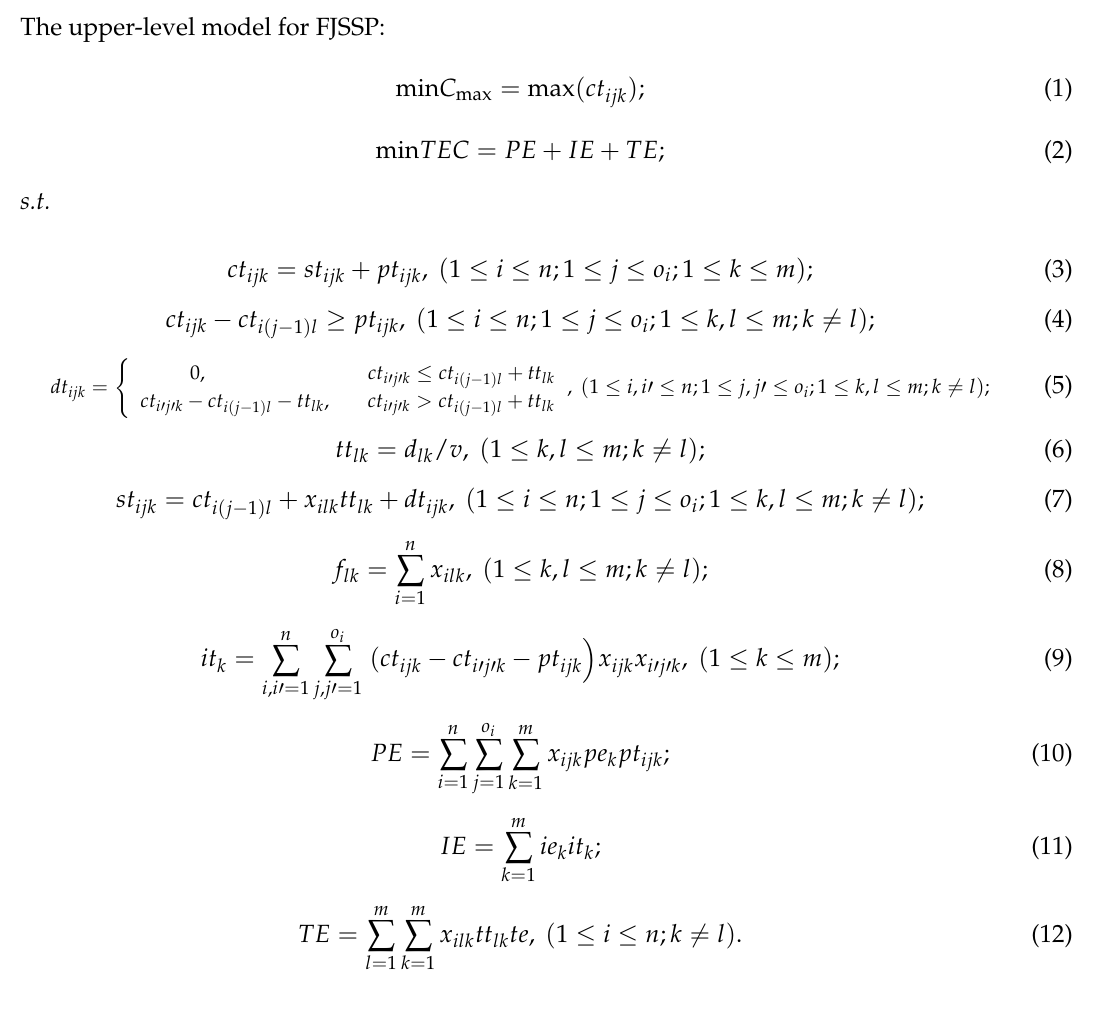
Figure 4. Structure of the proposed bi-level